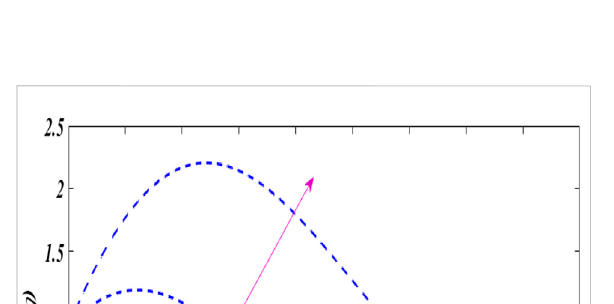
FIGURE 11 Dual solutions impact on for several.